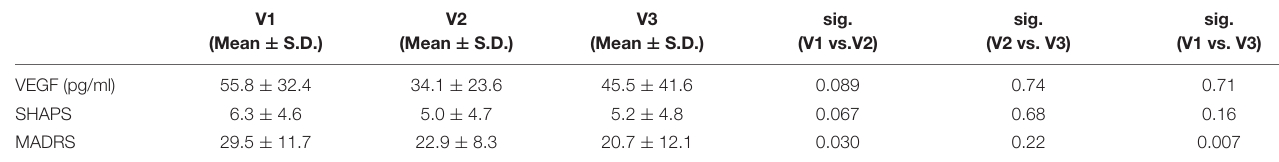
TABLE 2 | Mean values of the serum VEGF levels and the phenotypic scores at the three visits (V1, V2, and V3). V1 V2 (Mean ± S.D.) (Mean ±